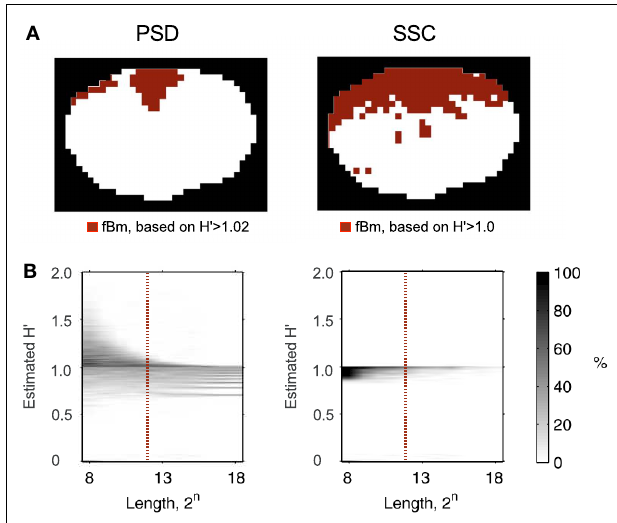
FIGURE 11 | Classifying rat fMRI BOLD data. Signal classification was performed on the 11.7T BOLD dataset shown in Figure 10 by the PSD and SSC methods (A) previous tested in this capacity by Eke et al. (2002); misclassification rates for PSD and SSC are shown in the plots of (B) the lower panel. Because SSC is a much better classification tool, than PSD is, the classification topology will be drastically different for these two methods.The ROI’s corresponding to voxel-wise signals identified by SSC as non-stationary indeed do clearly delineate the anatomical boundaries of the brain cortex, while those by the PSD only the spots of highest β